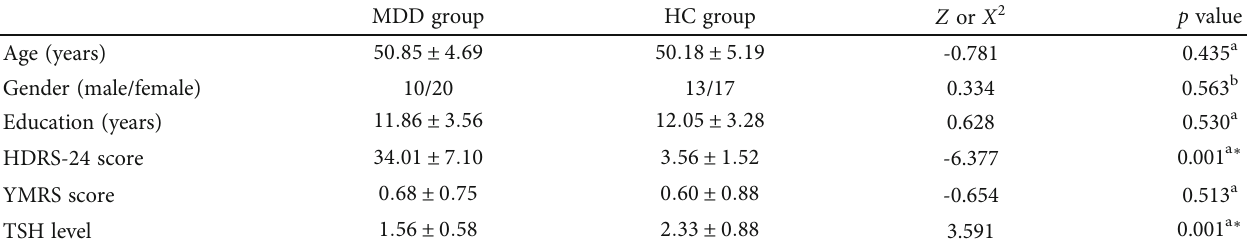
Table 1: Demographic information, clinical data, and TSH level of subjects ( mean ± SD ).